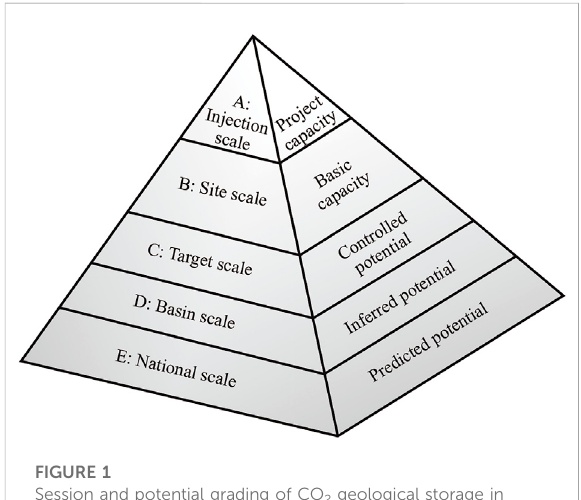
FIGURE 1 Session and potential grading of CO 2 geological storage in China (national scale (E) , basin scale (D) , target scale (C) , site scale (B) , and injection scale (A)